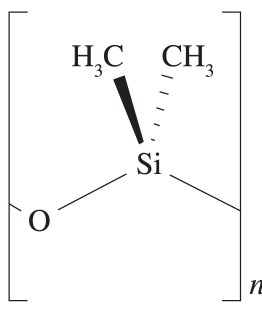
Figure 6. Polydimethylsiloxane structural